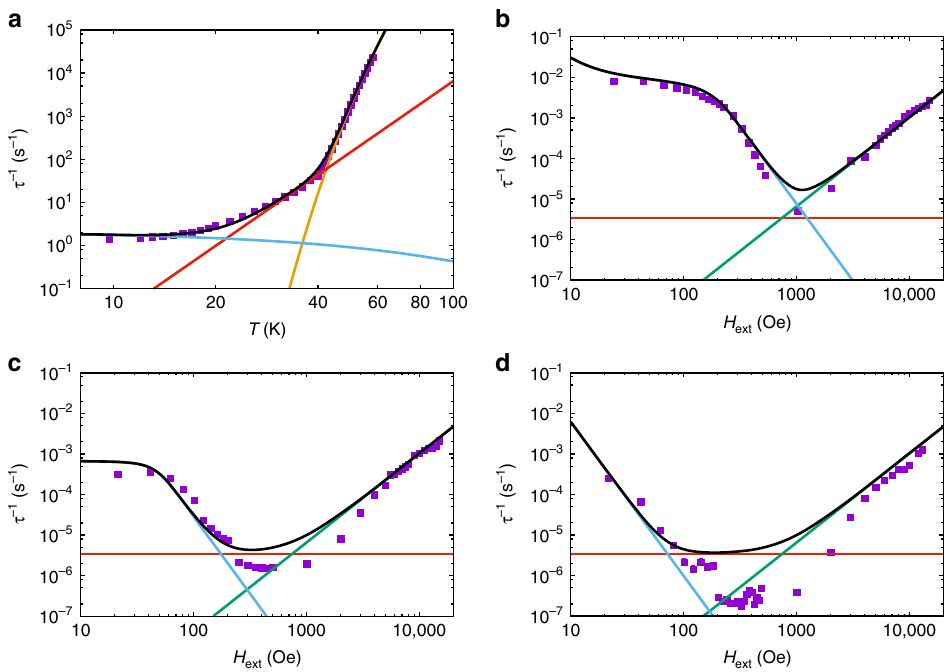
Fig. 6 Modelling of magnetic relaxation. a Magnetic relaxation rate measured by AC magnetometry for 1 at H ext = 0 Oe (note the log – log scale). b Magnetic relaxation rate measured by DC magnetometry for 1 at 2 K (note the log – log scale). c Magnetic relaxation rate measured by DC magnetometry for 1a (note the log – log scale). d Magnetic relaxation rate measured by DC magnetometry for 1b (note the log – log scale). For all plots: black line is a fi t with Eq. (4) using the parameters in Table 1; orange line is the Orbach component alone, red line is the Raman component alone, green line is the Direct component alone, blue line is the QTM component alone. Error bars are within the data